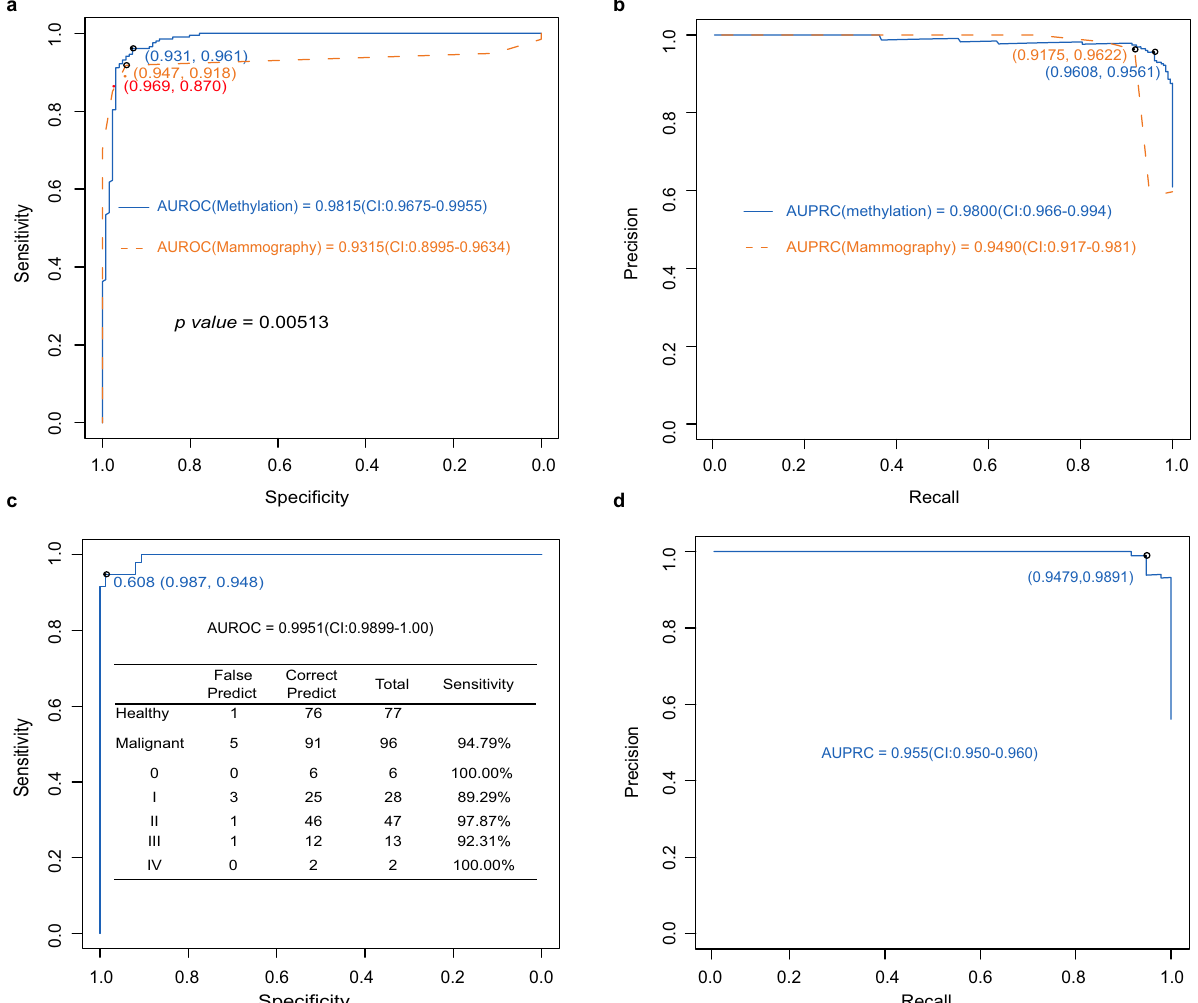
Fig. 5 Diagnostic power comparison of methylation markers and mammography. a, b The methylation panel has better diagnostic power [AUROC = 0.9815 (95% CI: 96.75 – 99.55%), and AUPRC = 0.9800 (95% CI: 96.6 – 99.4%)] than mammography [AUROC = 0.9315 (95% CI: 89.95 – 96.34%), and AUPRC = 0.9490 (95% CI: 91.7 – 98.1%)]. c , d The methylation markers and mammography combined model has obvious advantages in speci fi city of 98.67% and sensitivity for different stage with AUROC of 0.9951 (95% CI: 98.99 – 100%) and AUPRC of 0.955 (95% CI: 95.0 –